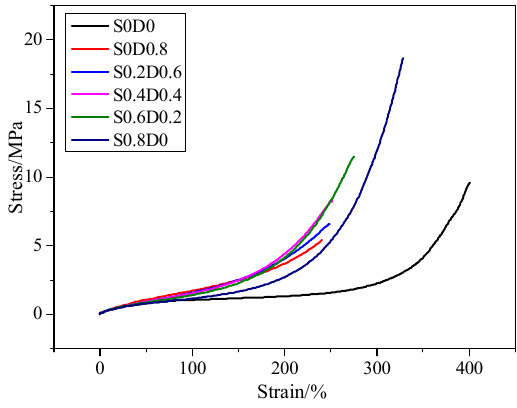
Figure 3. The stress-strain curves of PNB at 24 °C. Table 3. Mechanical properties of PNB at 24 ◦ C.